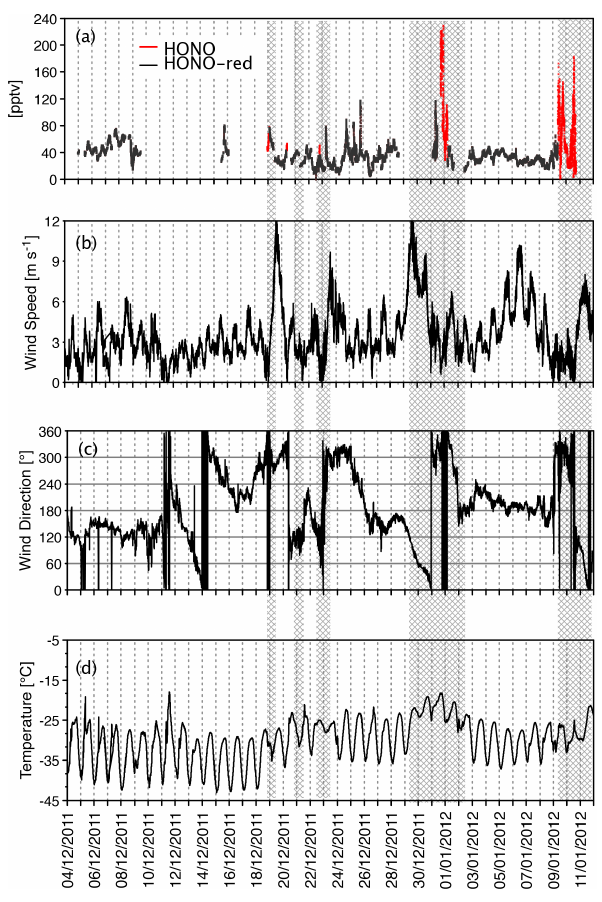
Figure 1. Summer 2011/2012 time series of HONO mixing ratios (1min average) (a) , wind conditions ( b and c ) and temperatures (d) at Concordia. Red points of the HONO record refer to time periods during which contamination from the station was possible with the wind blowing from the north (10 ◦ W to 60 ◦ E sector; see Sect. 2.2). Grey backgrounds indicate time period of overcast